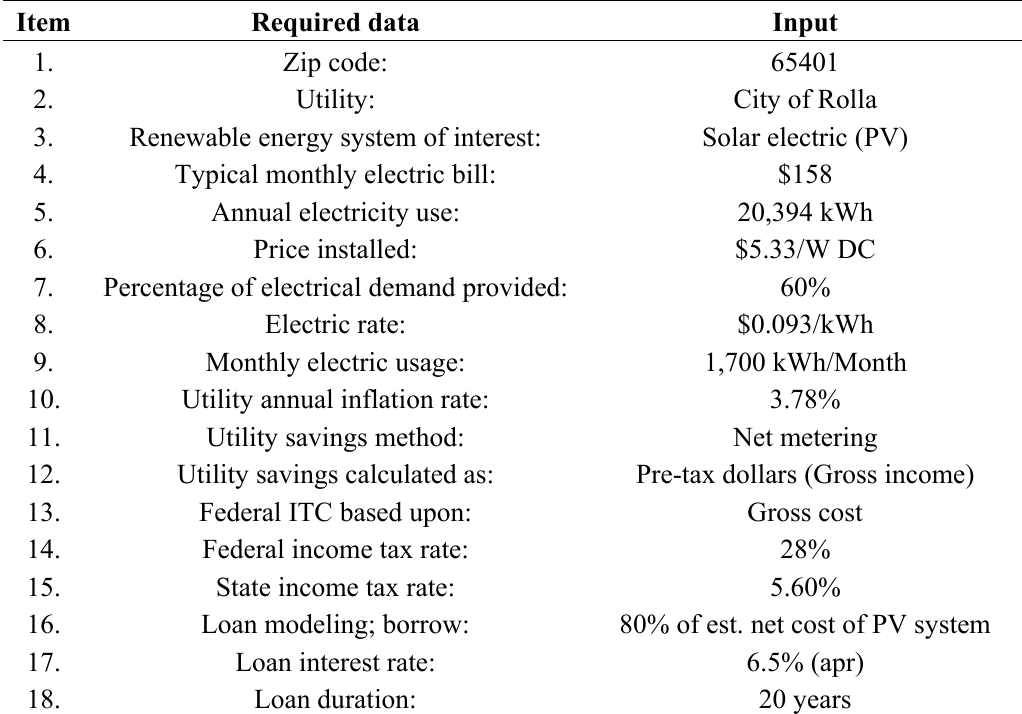
Table 4. Input data for solar-estimate.org solar PV system